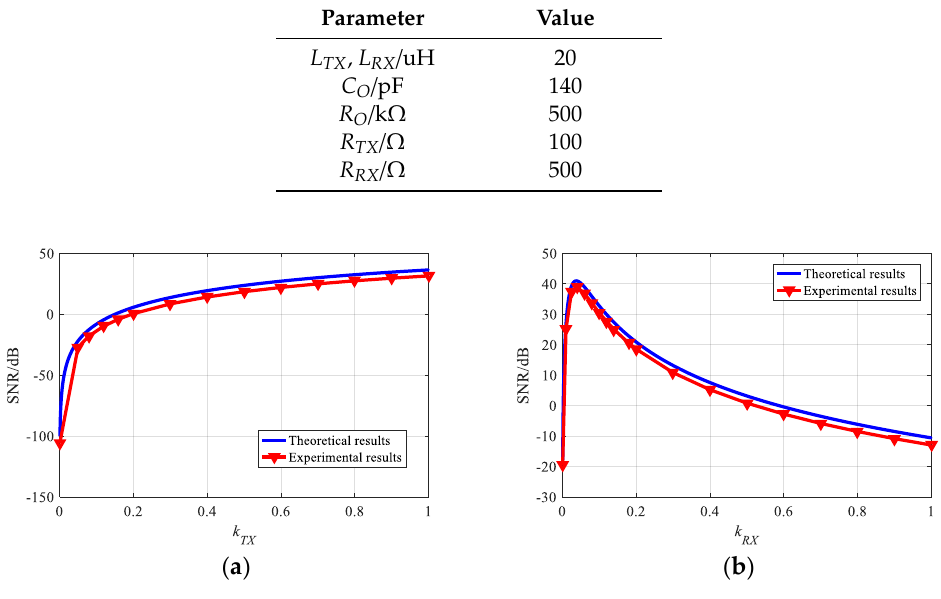
Table 2. Parameters of Data Transfer Channel.